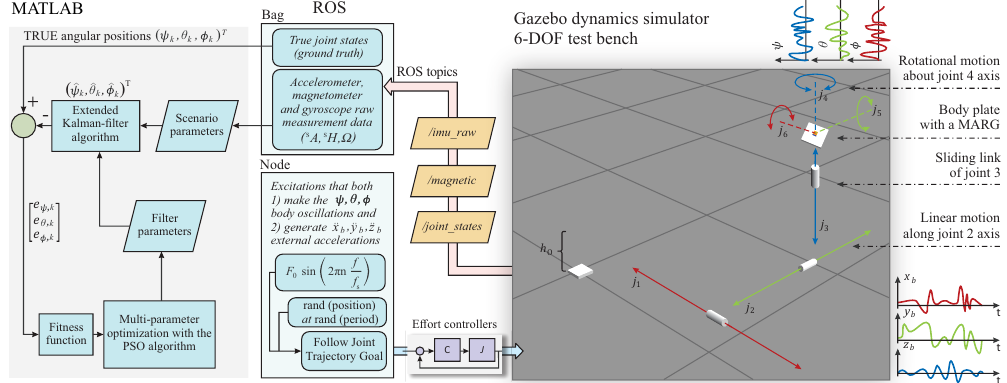
Figure 5. Block diagram of the test environment and filter tuning procedure (video of the closed-loop in